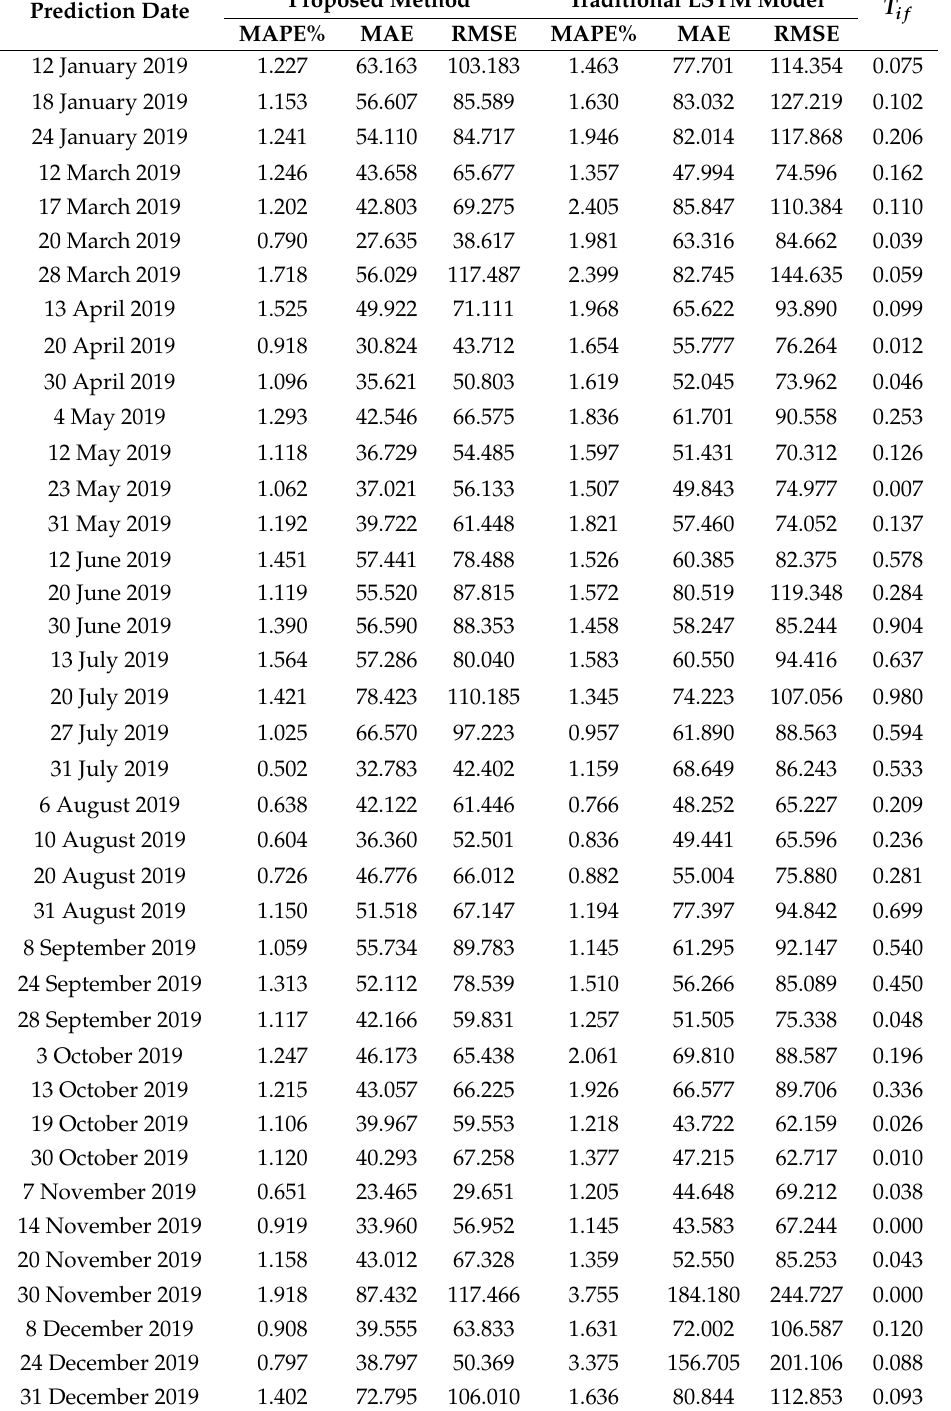
Table 3. Experimental result from January to